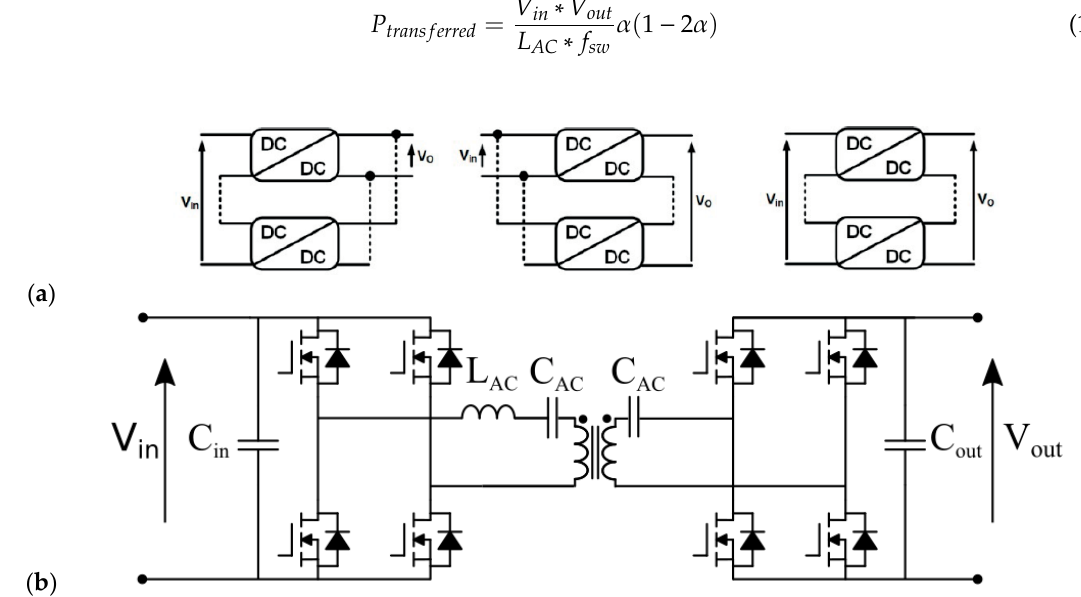
Figure 1. ( a ) Input series/output parallel (ISOP), input parallel/output series (IPOS) and input series/output series (ISOS) configuration illustration, ( b ) topology of a dual active bridge (DAB) converter.